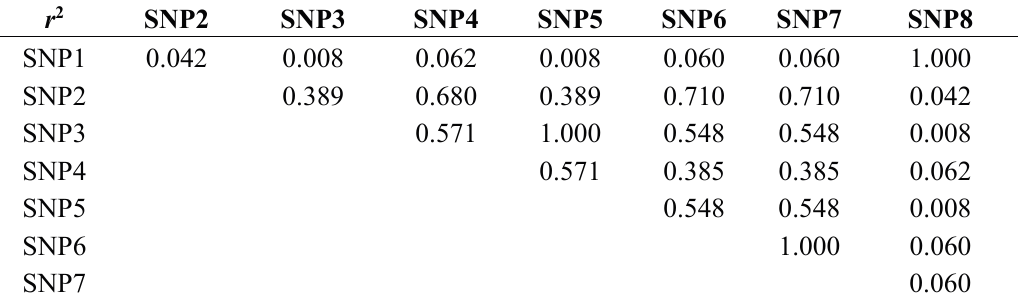
Table 2. Estimated values of linkage disequilibrium analysis for eight detected